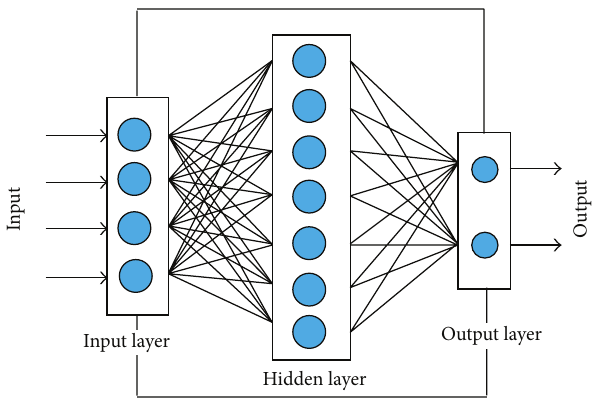
Figure 4: Structure of CFBP